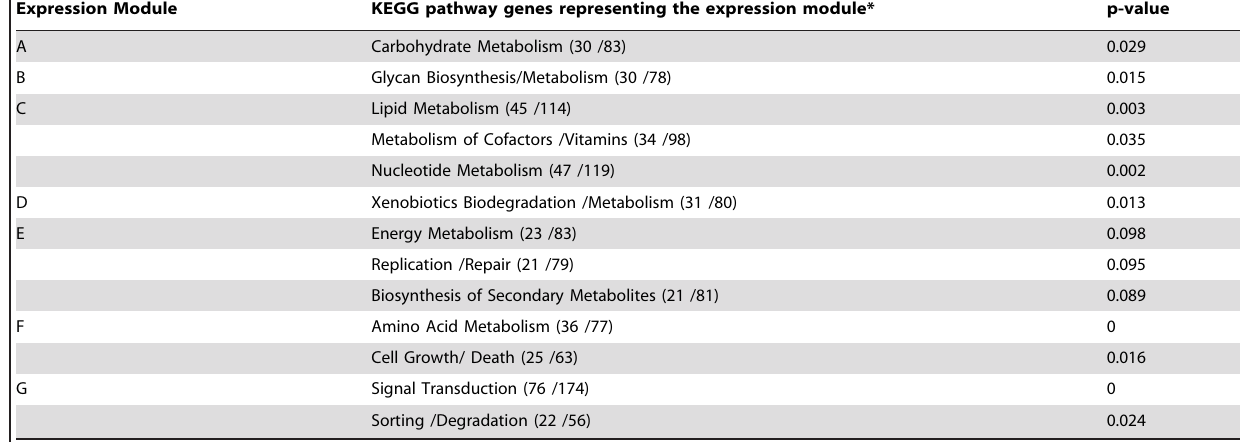
Table 2. Representation of pathway genes in expression modules.